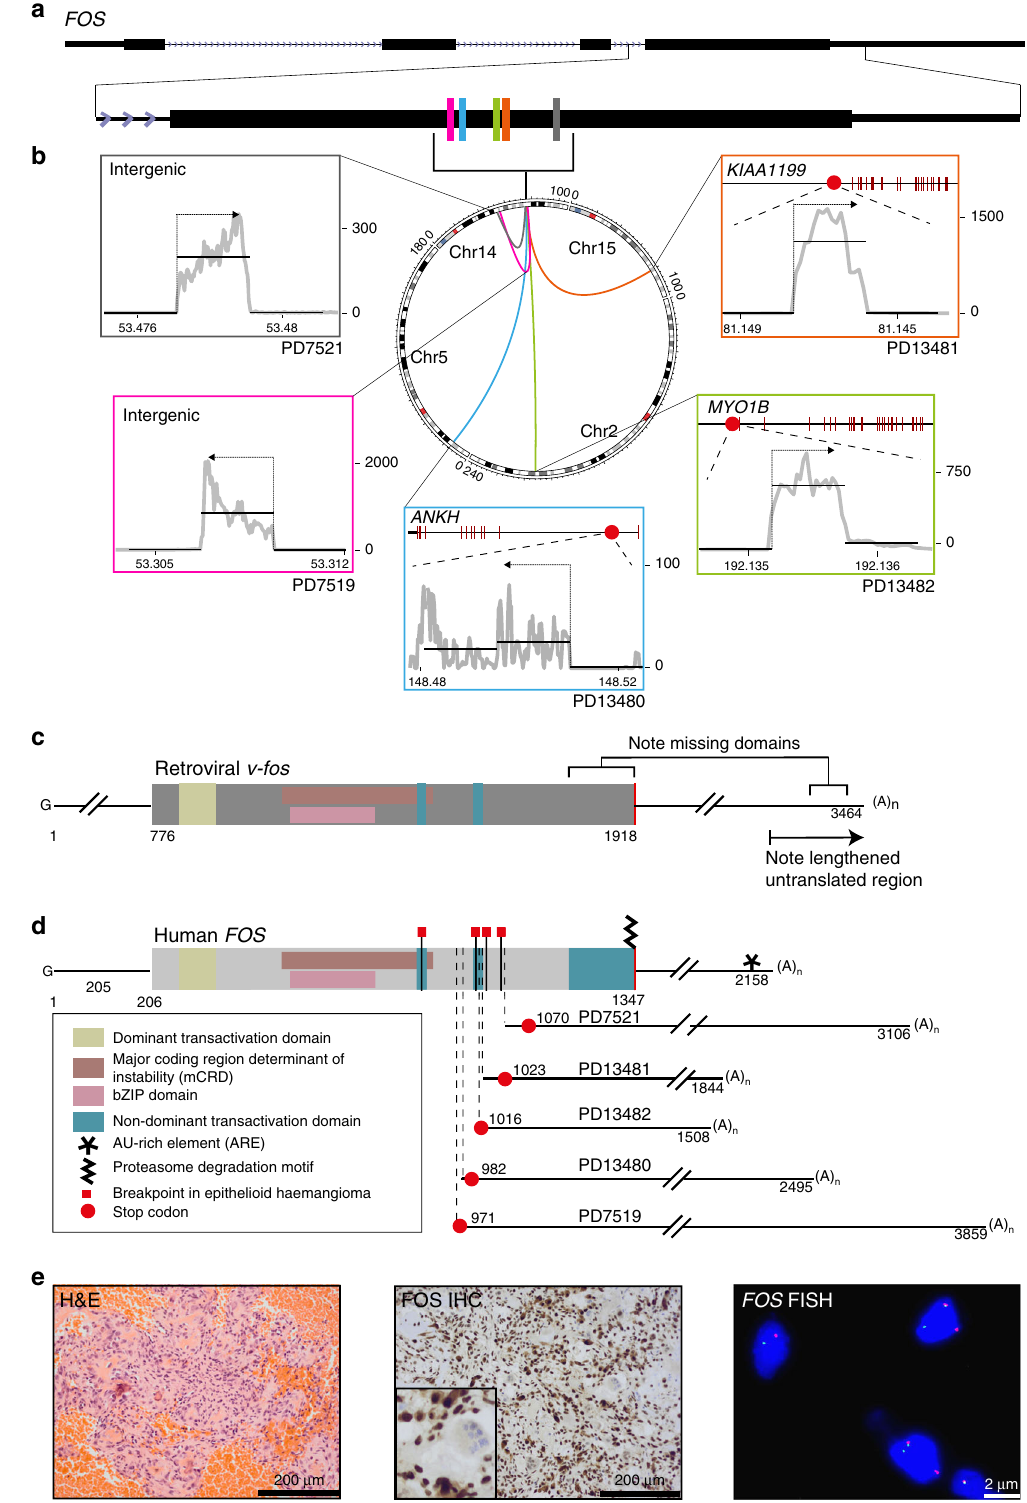
Fig. 1 FOS fusions in osteoblastoma. a Clustered break points in FOS . b Central Circos plot showing the clustering of break points in FOS -mutant samples. All structural variants involving chromosome 14 are shown, demonstrating the paucity of genomic rearrangements. Surrounding panels demonstrate normalised RNA-Seq read counts for each fusion partner. Horizontal line segments re fl ect mean sequencing counts. The arrow above shows the direction of transcription of the fusion. c Retroviral v-fos . d Schematic of FOS break points in benign bone and vascular tumours generating similarity with the murine retroviral transforming v-fos . Subscript numbers from left to right report the length of the transcript to the stop codon and the predicted cleavage and poly- adenylation site, respectively. e FOS immunohistochemistry demonstrating strong nuclear immunoreactivity in FOS -mutant osteoblastoma, PD13482 (centre with zoom inset), Haematoxylin and eosin (H&E) (left), and a clear breakapart of FISH probes surrounding the FOS locus